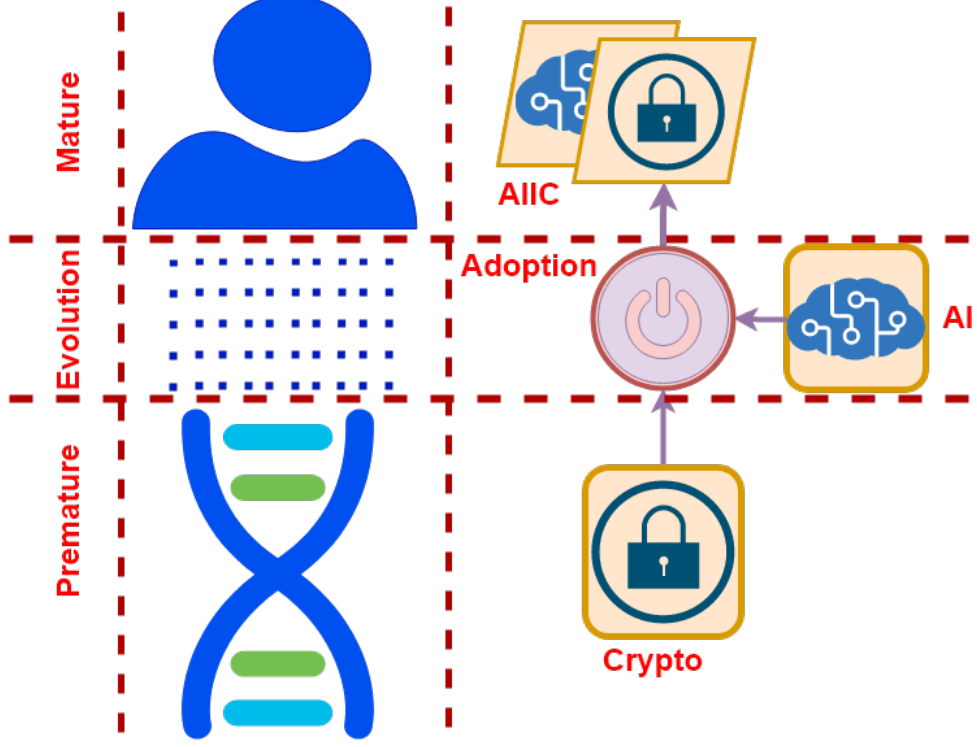
Figure 1. Crypto Makes AI